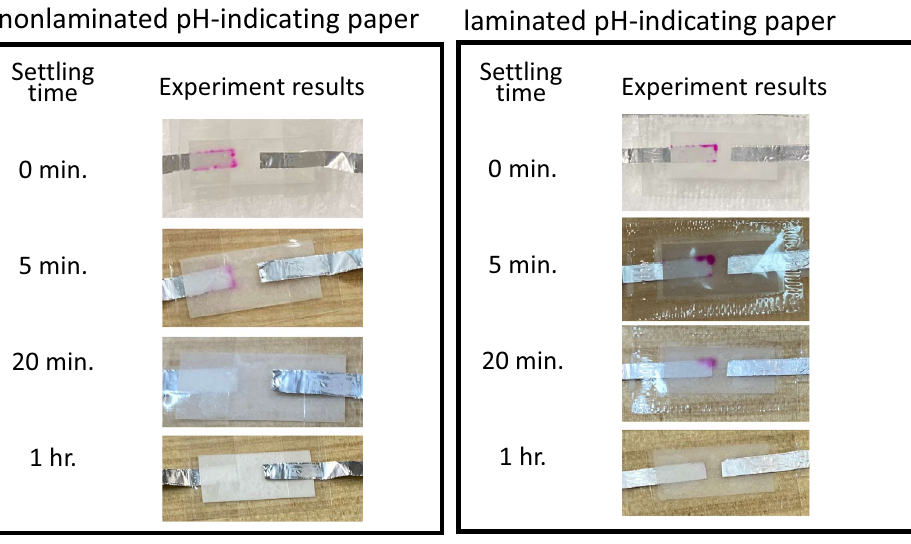
Figure 11. Color retention time of the proposed color-change RFID tag with the nonlaminated/laminated phenolphthalein pH-indicating